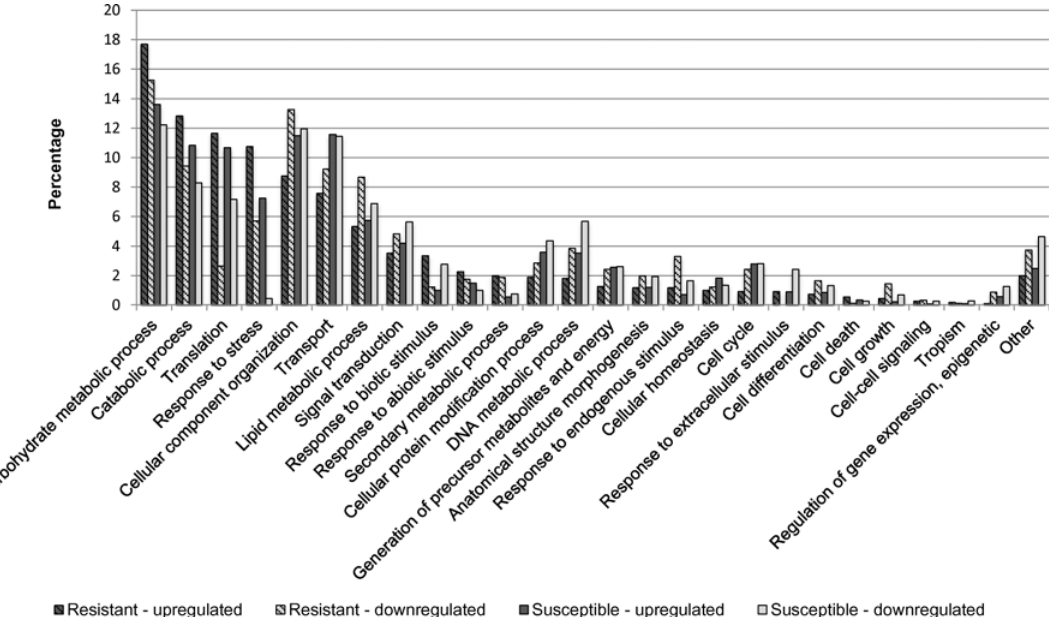
Fig 7. Percentage of upregulated and downregulated transcripts in the nickel — resistant and susceptible Betula papyrifera genotypes compared to control (nickel untreated samples). Transcripts were assigned gene ontology and grouped by biological function using